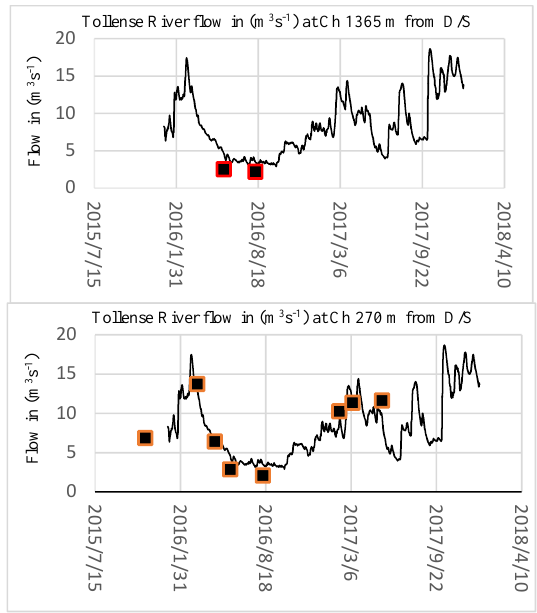
Figure 11. Observed (black squares) and simulated river (continuous black line) flows in the Tollense River catchment.